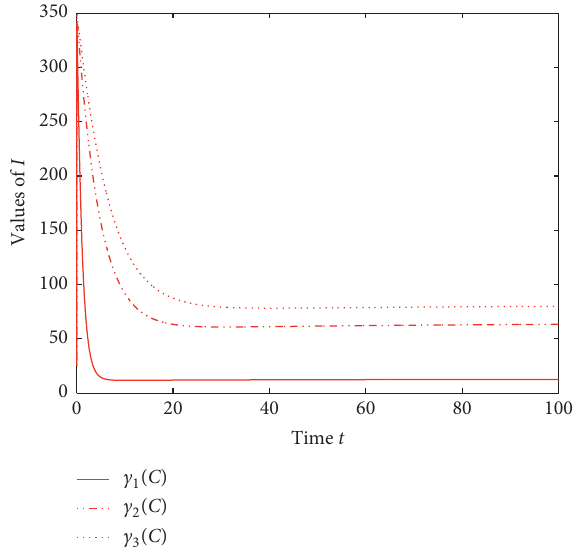
Figure 5: The impacts of the varied countermeasure probabilities on I